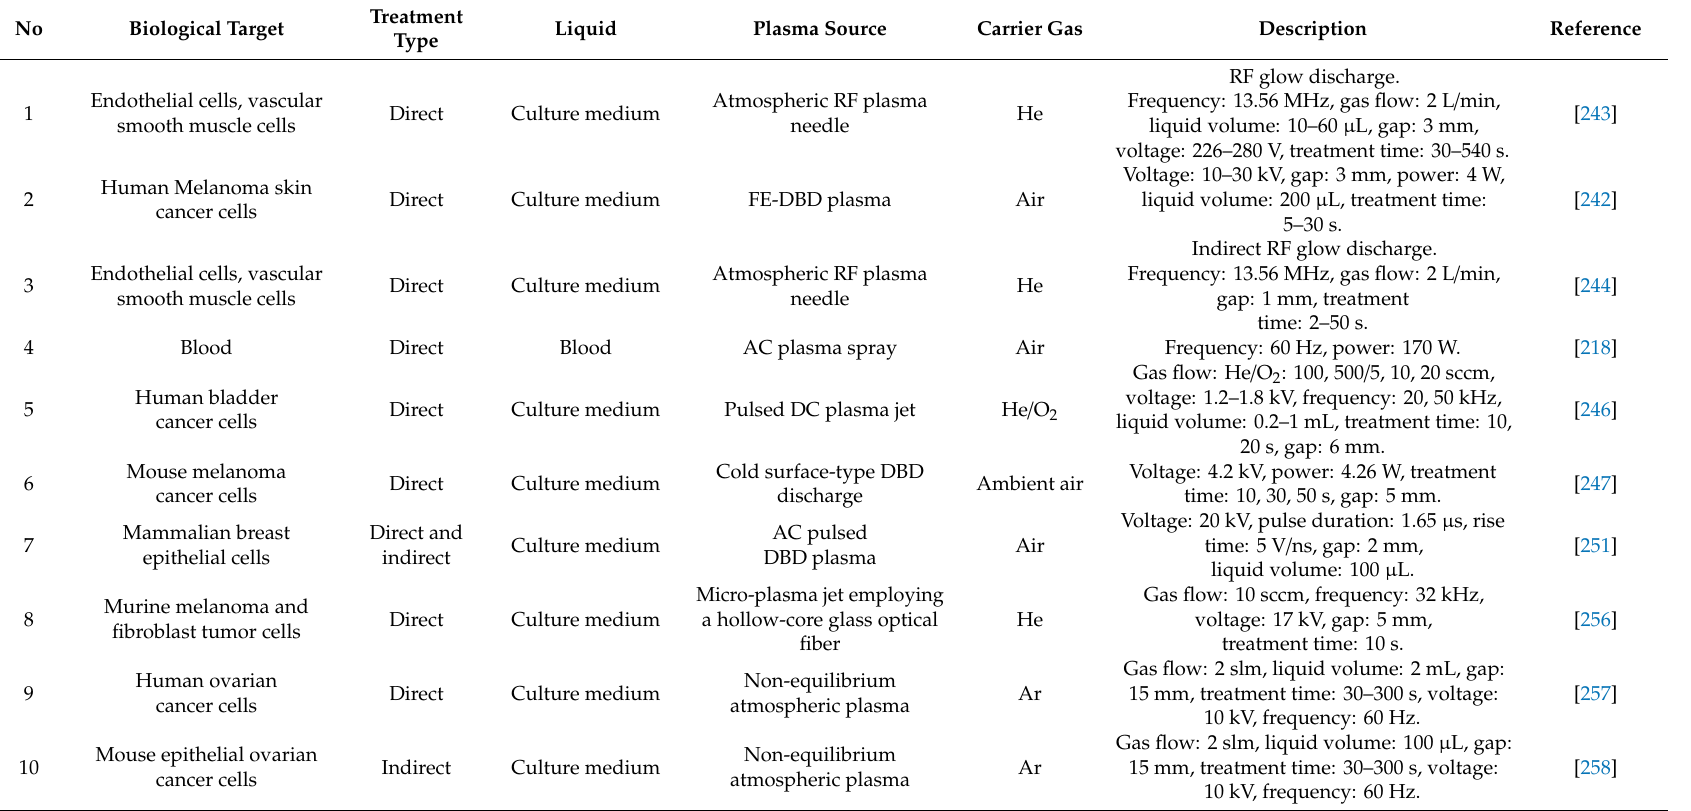
Table 7. Overview of studies dealing with plasma–biological liquid interactions envisioning cancer